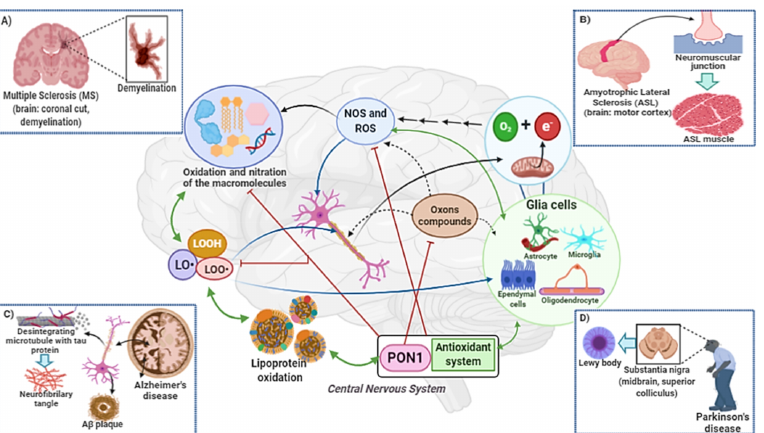
Figure 4. The consumption of oxygen by the brain is high. O 2 is used in oxidative phosphorylation to produce energy in the form of ATP in mitochondria. ATP is used to maintain membrane potential, the flow of neurotransmitters and the synapse in neurons. During the ATP synthesis process, occurs electron (e-) leakage of the electron transport chain. The free electron reacts with oxygen and forms the superoxide radical (O 2 •− ). Then, hydroxyl radical formation can occur from the Fenton and Haber–Weiss reactions. Reactive oxygen species (ROS) and reactive nitrogen species (NOS) react with macromolecules: Lipids, proteins, carbohydrates and DNA. Lipid peroxidation of polyunsaturated fatty acids results in the accumulation of lipid hydroperoxides (LOOH). In the degradation of LOOH, the formation of alkoxyl (LO • ) and peroxyl (LOO • ) radicals occurs, highly reactive with proteins and lipid members. This process is widespread and can occur anywhere in the brain. Initially, it changes neuronal and glial cell function, and then cell death. In addition, in the lipid peroxidation process cytotoxic aldehydes are formed. Cellular metabolism generates O2 •− , H 2 O 2 and NO • , that can react and oxidize neurotransmitters. Under physiological conditions, the CNS antioxidant systems (superoxide dismutase (SOD), catalase (CAT), glutathione (GSH) and PON1) are able to maintain tissue homeostasis. However, when dyshomeostasis occurs, either by an increase in toxic substances (such as organophosphate compounds) and/or oxidative stress, dysregulating lipid homeostasis, then the neurodegeneration process begins. Increased oxidative stress and decreased activity of antioxidant enzymes, such as PON1, are strongly associated with the pathophysiology of multiple sclerosis ( A ), amyotrophic lateral sclerosis ( B ), Alzheimer’s disease ( C ) and Parkinson’s disease ( D ). Apolipoproteins have been associated with neurodegenerative diseases, Table